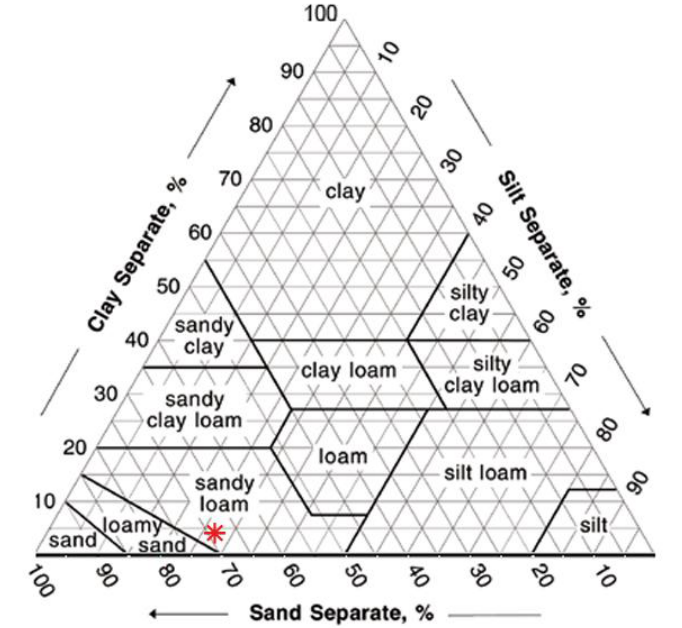
Figure 4. Soil texture triangle, showing the 12 major textural classes